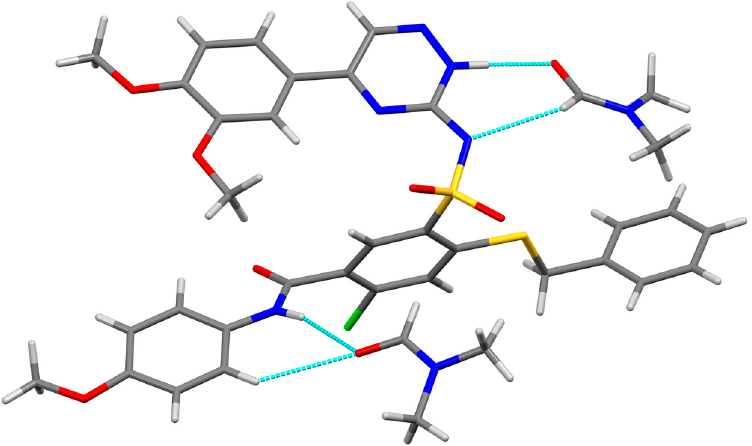
Figure 2. View of half of the independent unit (one sulfonamide and two DMF molecules) showing the general arrangement of atoms in 59 and N–H···O type hydrogen bonds.